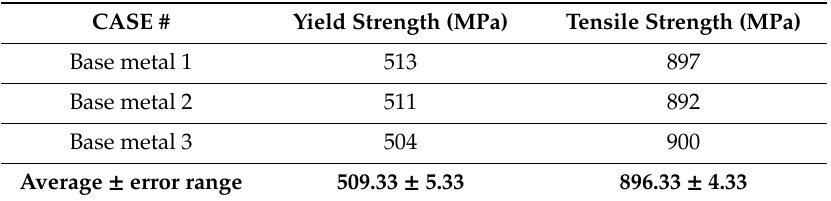
Table 9. Yield and tensile test results of high-manganese steel base